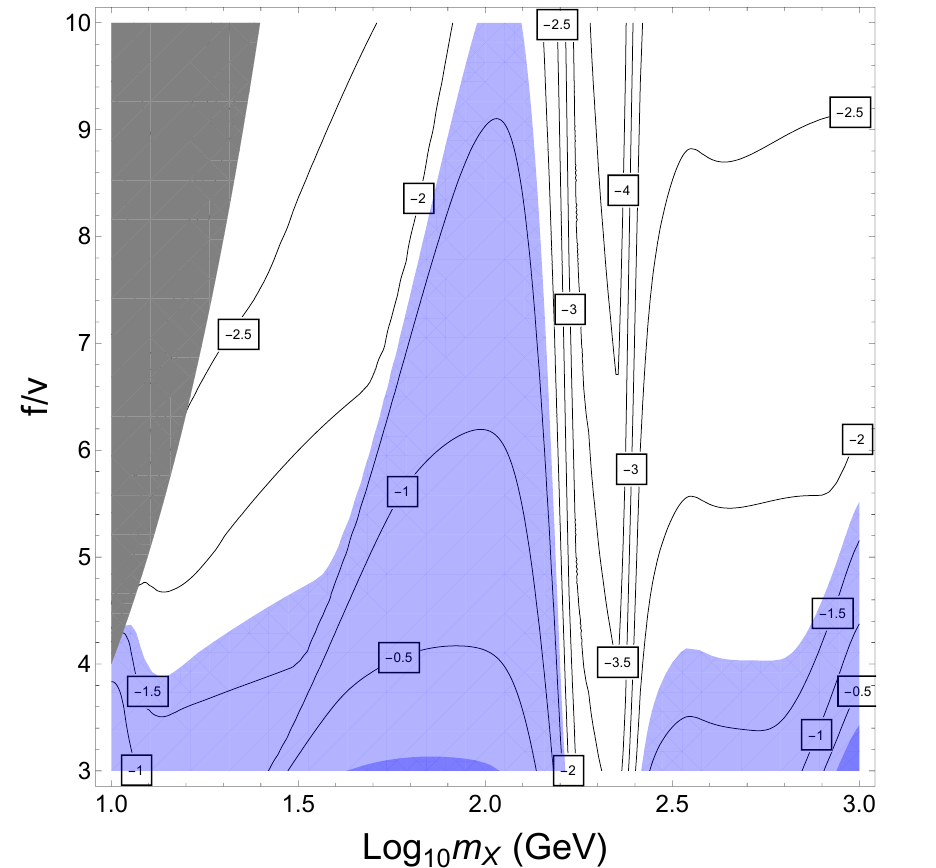
Figure 8 . Contours of log (cid:1) N e(cid:11) as a function of m X and f=v , for T SM 10 blue region is in tension with Planck, while the light blue region will be tested by CMB-S4. Gray regions are where the X mass is below the twin charm threshold and our calculation of the twin sector partial width is